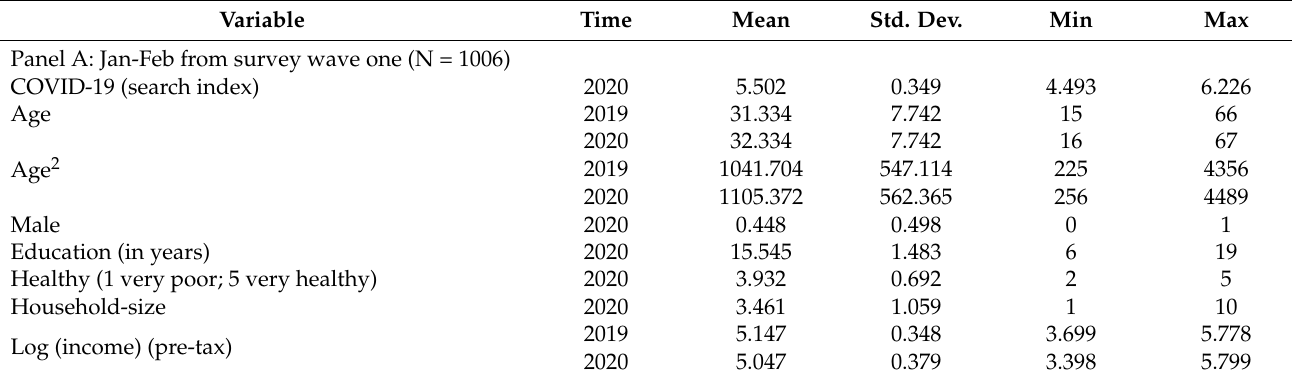
Table 1. Variable and descriptive